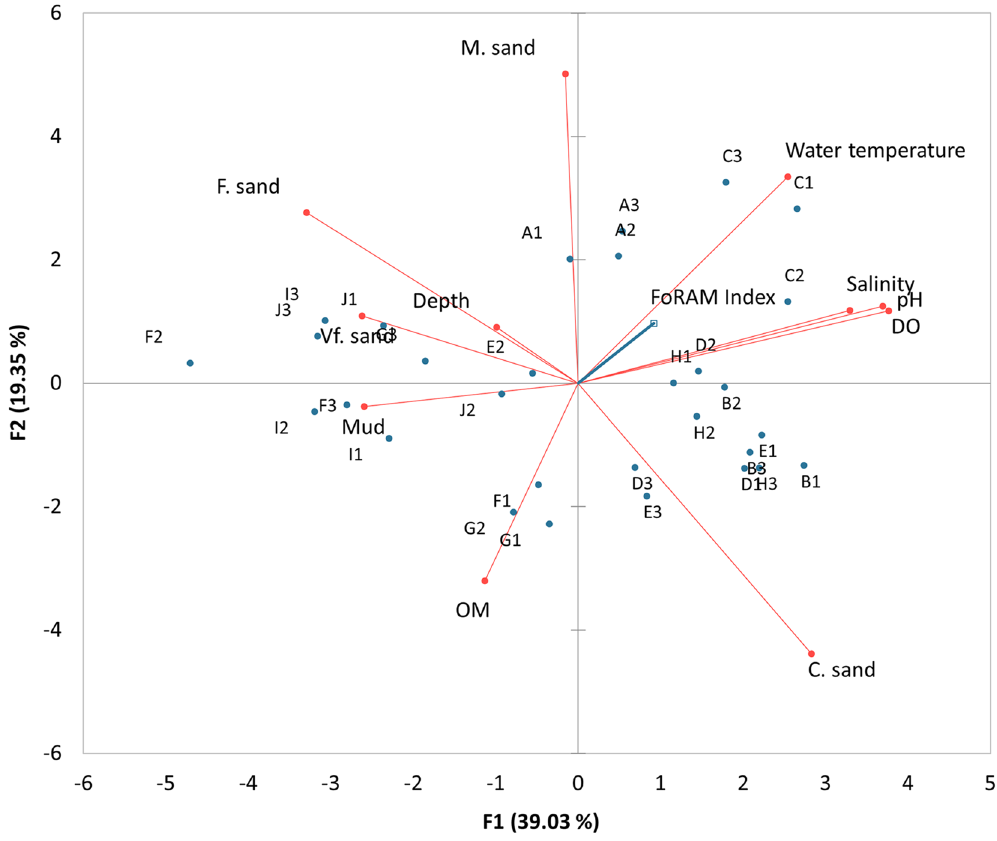
Figure 2. Principal component analysis (PCA) of sediment and water quality and FI data from study area around Pulau Tioman. The variation explained by both axes 1 and 2 is 58.38%. OM-organic matter; C. sand- coarse sand; DO- Dissolved oxygen; M. sand- Medium sand; F. sand- Fine sand; Vf, sand- Very fine